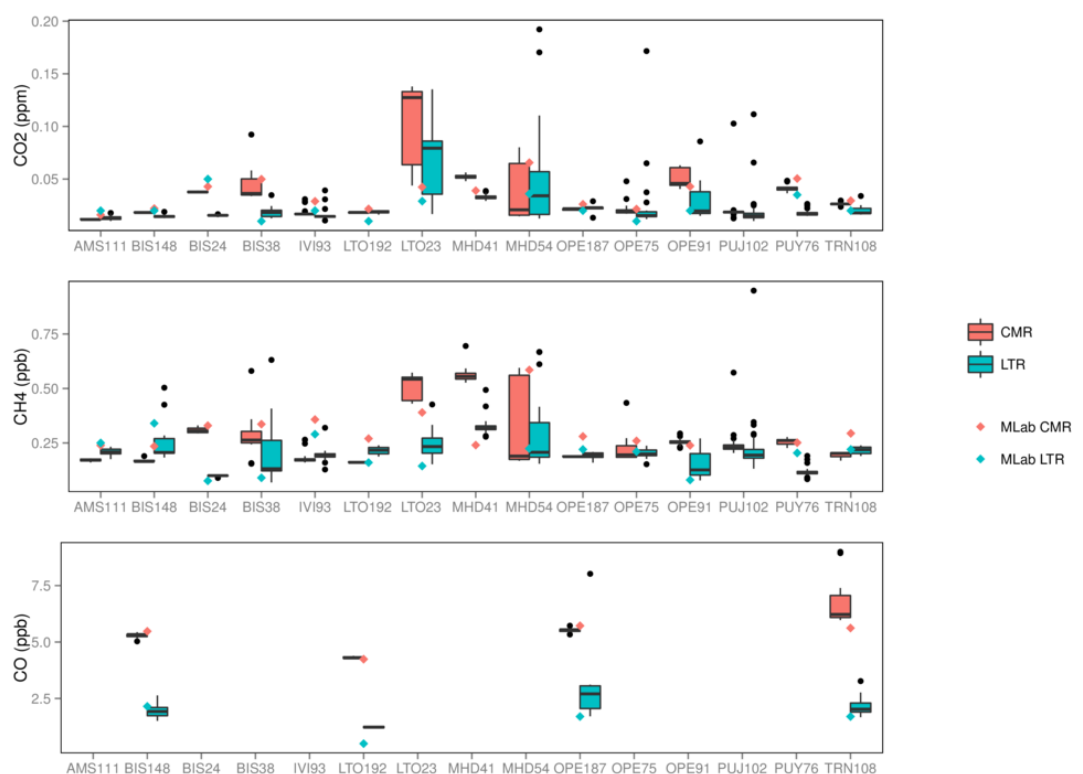
Figure 13. Top: CO 2 . Middle: CH 4 . Bottom: CO. For each field instrument, we show the statistics as defined in Fig. 6 for the CMR and LTR during the measurement period. The MLab initial values are added with diamond shapes.